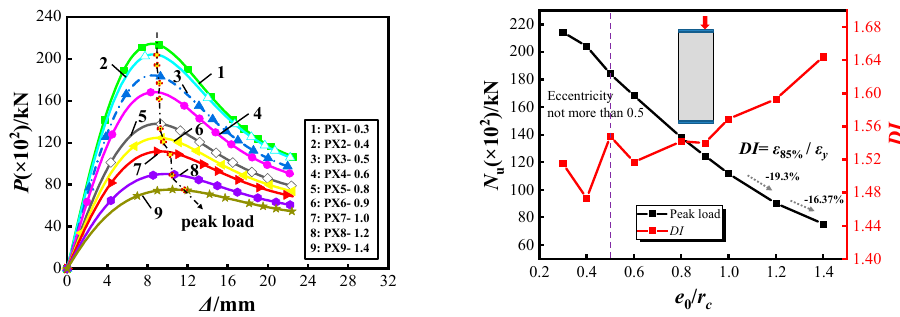
Figure 23. Load–displacement curves with different eccentricities.